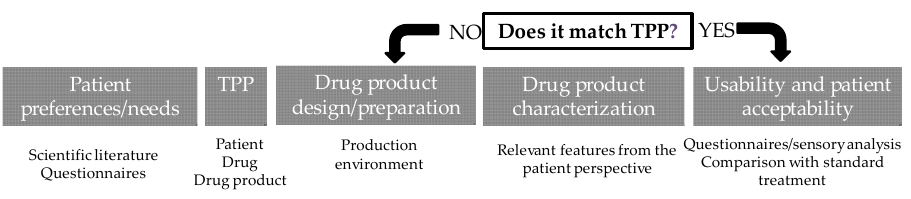
Figure 1. Patient-centric drug-product-design stepwise approach.